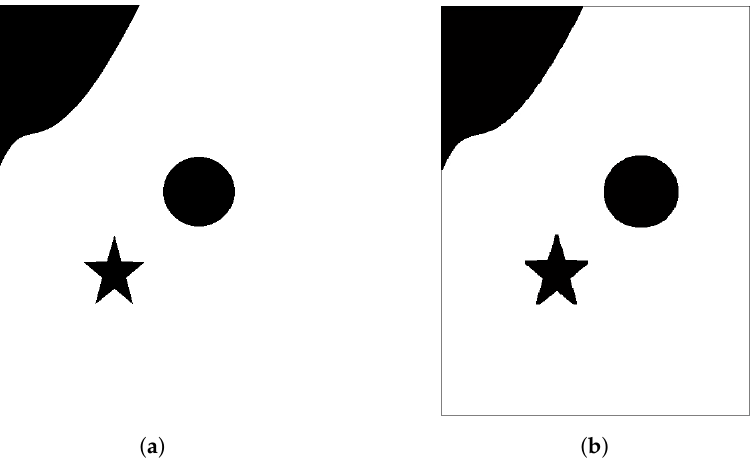
Figure 2. The simulation environment. ( a ) The initial binary map; ( b ) The expanded